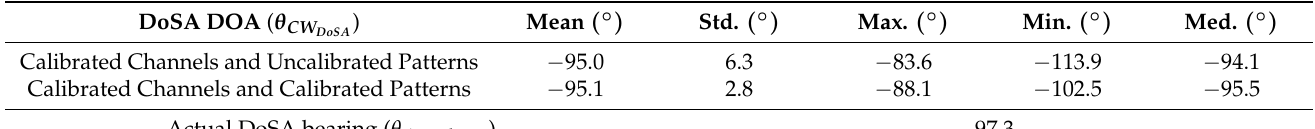
Figure 11. From 1300 UTC+8 25 December 2016 to 1300 UTC+8 26 December 2016: ( a ) DoSA DOA without any calibration (black line) compared with the actual DoSA bearing (blue line); ( b ) DoSA DOA before pattern corrections (black line) and after pattern corrections (red line) compared with the actual DoSA bearing (blue line). Table 2. DoSA DOA statistics using the uncalibrated and calibrated